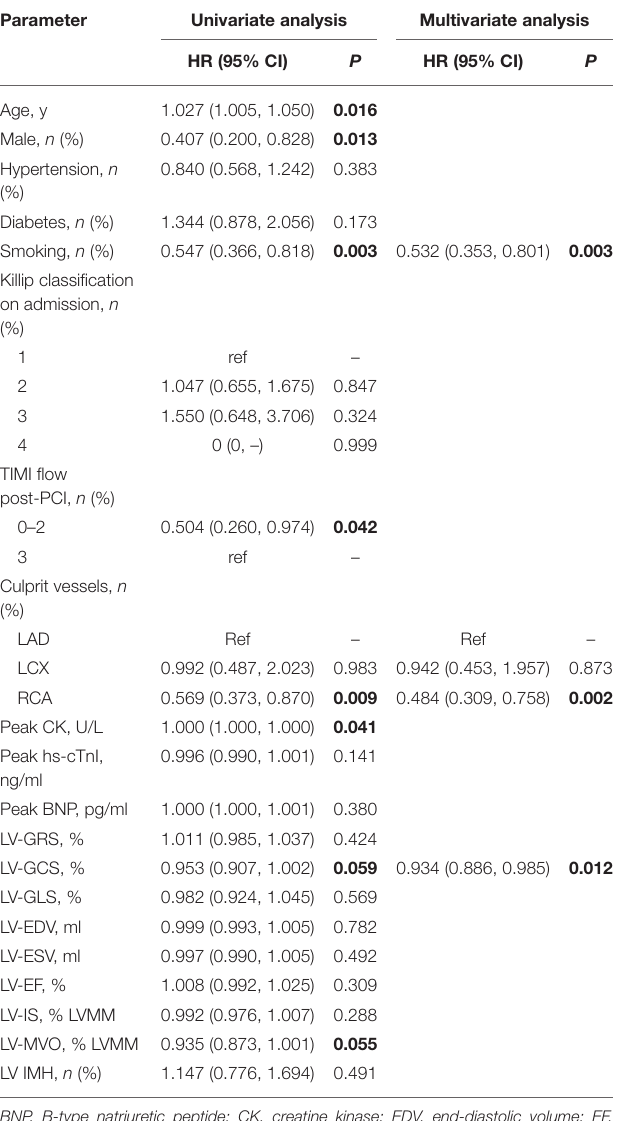
TABLE 4 | Logistic regression analysis of RV-GRS impairment.